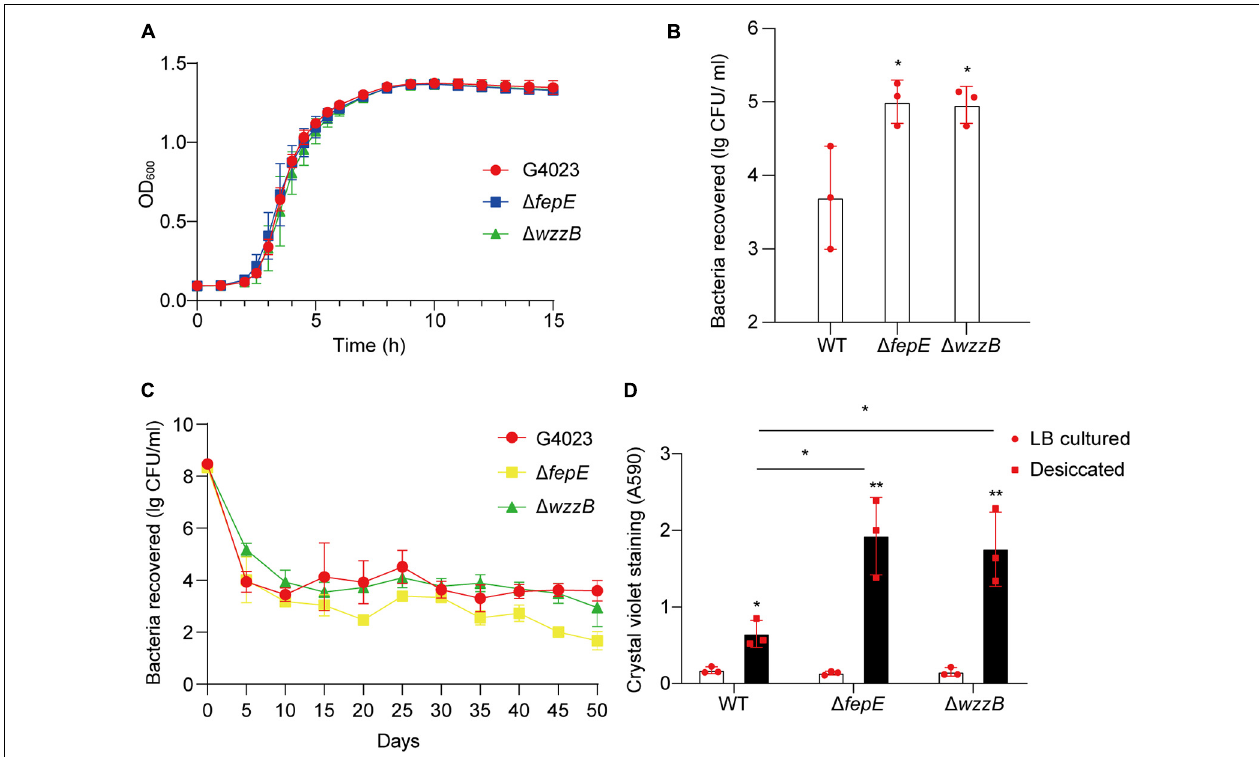
FIGURE 8 | The role of O-antigen chain length-regulation genes in the desiccation tolerance of C . sakazakii G4023. (A) Growth curves of C . sakazakii wild-type (WT) strain G4023, G4023 (cid:49) fepE , and G4023 (cid:49) wzzB in LB medium at 37 ◦ C with shaking; OD600 measurements were done every 10 min. There were no differences in the growth of G4023, G4023 (cid:49) fepE , and G4023 (cid:49) wzzB . (B) Re-cultured cell counts (CFU/ml) of C . sakazakii WT strains G4023, G4023 (cid:49) fepE , and G4023 (cid:49) wzzB in LB agar medium after being desiccated for 4 days. All of the three strains could survive desiccation, and the desiccation tolerance of G4023 (cid:49) fepE and G4023 (cid:49) wzzB was significantly stronger than that of wild-type strain. (C) Progress curve of culturable cell counts during the desiccation of WT G4023, G4023 (cid:49) fepE , and G4023 (cid:49) wzzB . The CFU were counted every 5 days, and 50 days of desiccation tolerance was studied in total. (D) Absorbances of crystal violet at 590 nm was used to assess the biofilm formation abilities of C . sakazakii WT strain G4023, G4023 (cid:49) fepE , and G4023 (cid:49) wzzB . Biofilm formation of LB cultured strains and desiccation-treated strains were detected separately. All the three strains showed significantly increased biofilm formation under desiccation stress. Desiccated G4023 (cid:49) fepE and G4023 (cid:49) wzzB formed more biofilms than the desiccated WT strain, although the three showed no significant difference in biofilm formation when cultured in LB medium. The error bars represent mean ± SD; n = 3. Differences between two groups were evaluated by a two-tailed Student’s t -test. A p -value of < 0.05 was considered statistically significant. Asterisks are used to indicate significant differences (* p < 0.05; ** p <